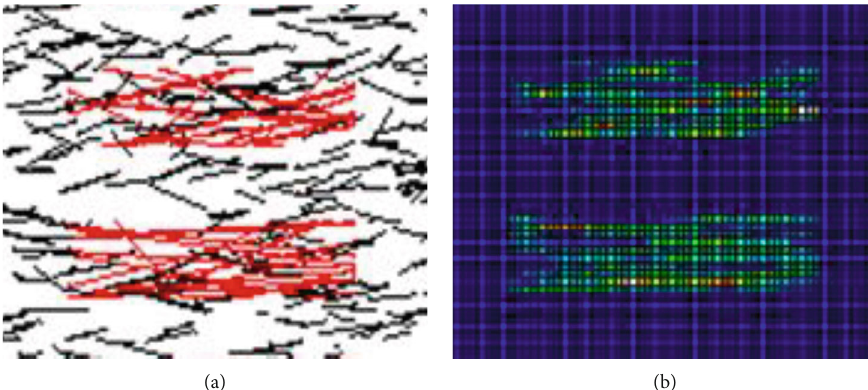
Figure 2: Complex fracture pattern generated by Fracman and coarsening result in reservoir simulation model.